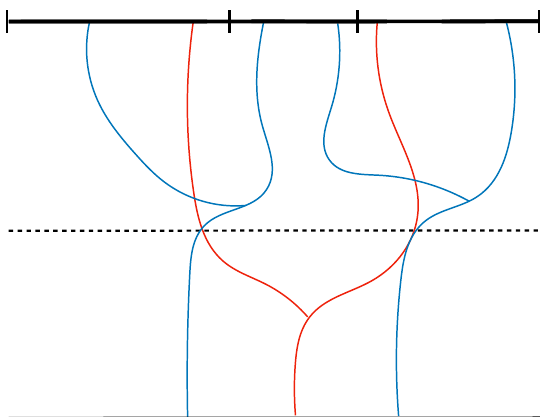
Figure 12 . A negative 3-thread (red) allows additional positive 3-threads (blue) across a potential bottleneck (dashed line). These are arranged such that the total density of the threads on this surface is zero. Together they would contribute 6 − 3 = 3 to an objective. This is made possible because the hyperthreads can split in different regions of the